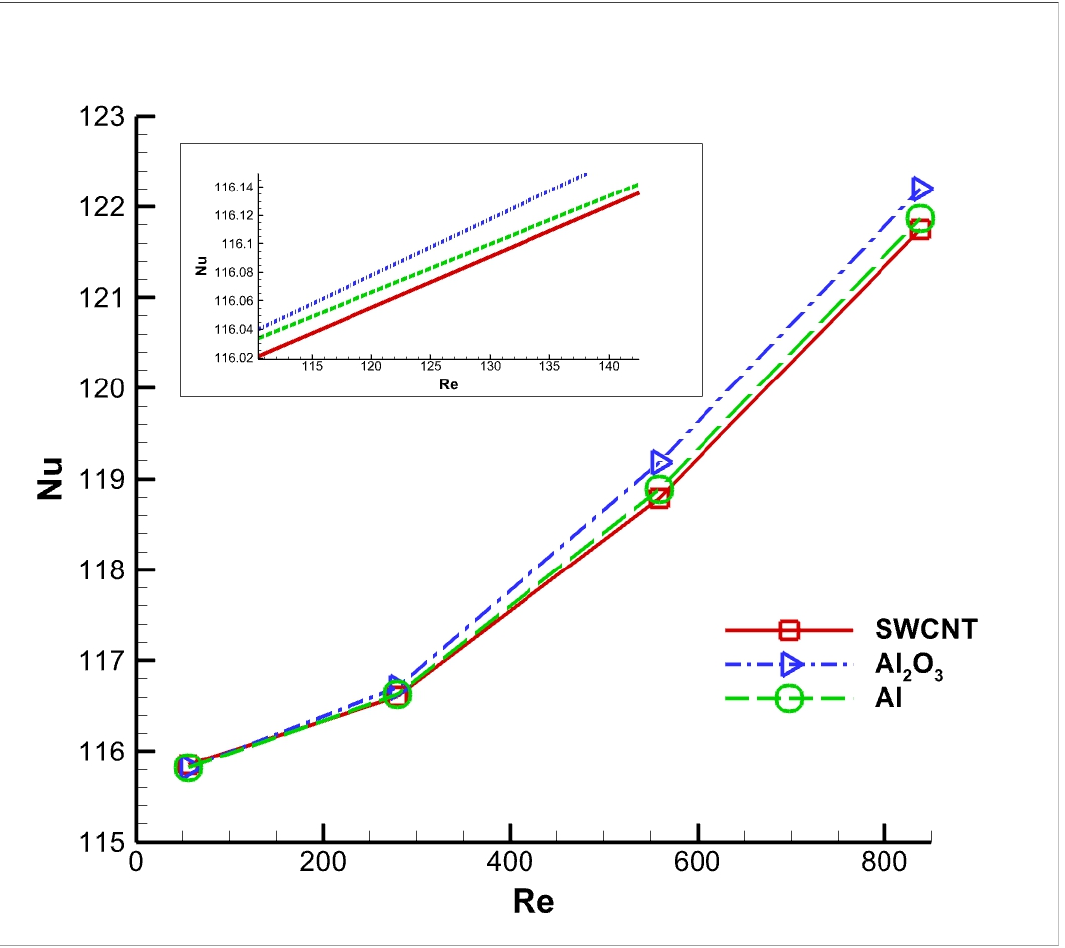
Figure 17. Variation in Nusselt number with respect to Reynolds number.